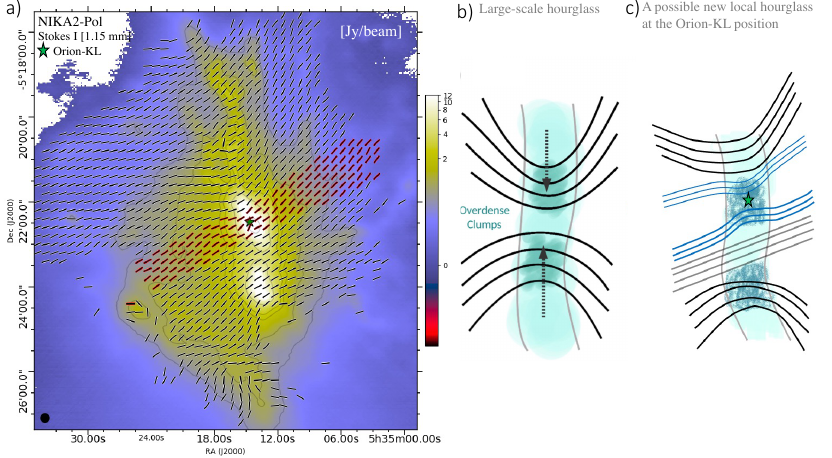
Figure 3. a-) Stokes I 1.15 mm map of OMC-1 region obtained from NIKA2-Pol polarization commis- sioning data, with magnetic field vectors at positions where I pol / σ I Figure 2. Di ff erences in B-field angle between NIKA2-Pol and POL2 data in OMC-1 at the same the possible new local hourglass revealed by NIKA2-Pol. b) : Illustration of the large-scale magnetic angular resolution (14 ′′ ) and for positions with high signal-to-noise ratio in polarized intensity ( I pol > field as seen by POL2 from Pattle et al. (2019). c) Schematic illustration of the large-scale hourglass 5 σ I for both NIKA2-Pol and POL2). a-) : Map of the di ff erences in B-field angle (NIKA2-Pol geometry as seen with NIKA2-Pol (in black lines) and the new possible local hourglass at the position pol − POL2). The overlaid black segments display di ff erence vectors plotted every 14 ′′ beam. b-) : Histogram of Orion-KL revealed by the high sensitivity and resolution of NIKA2-Pol (in blue of the di ff erences in B-field angle (NIKA2-Pol POL2). The amplitude of the di ff erence in B-field −